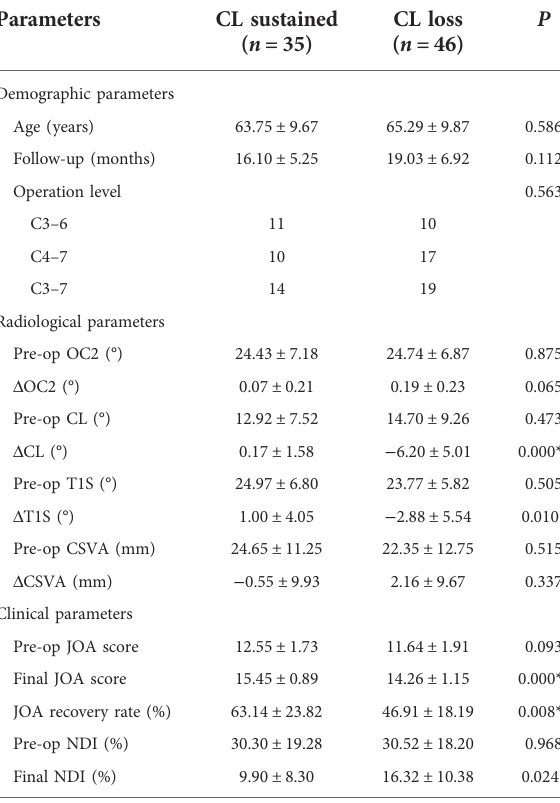
TABLE 3 Comparison of radiological parameters and clinical parameters between the CL sustained group and the CL loss